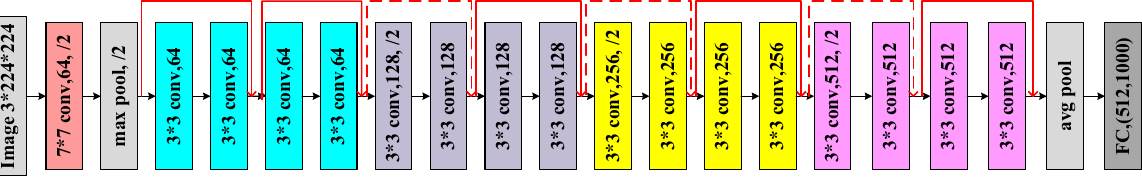
Figure 2. The ResNet-18 framework.